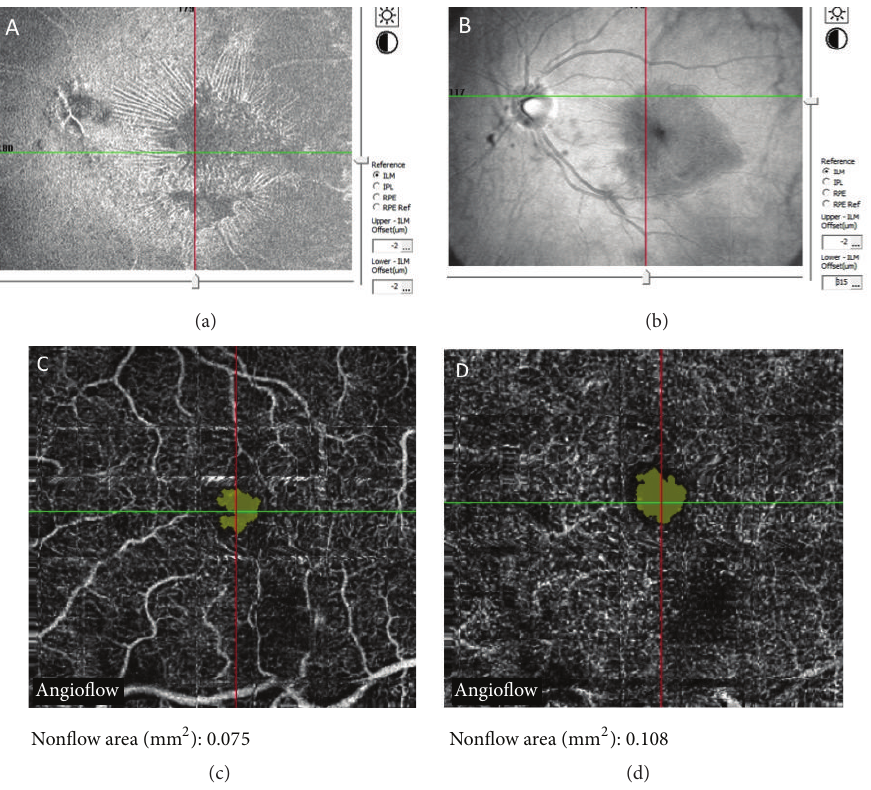
Figure 7: (a)-(b) iERM on en face OCT images at different segmentation thicknesses; at 315 microns offset from ILM the traction disappears (b); (c)-(d) angio-OCT images of retinal superficial plexus (c) and retinal deep plexus